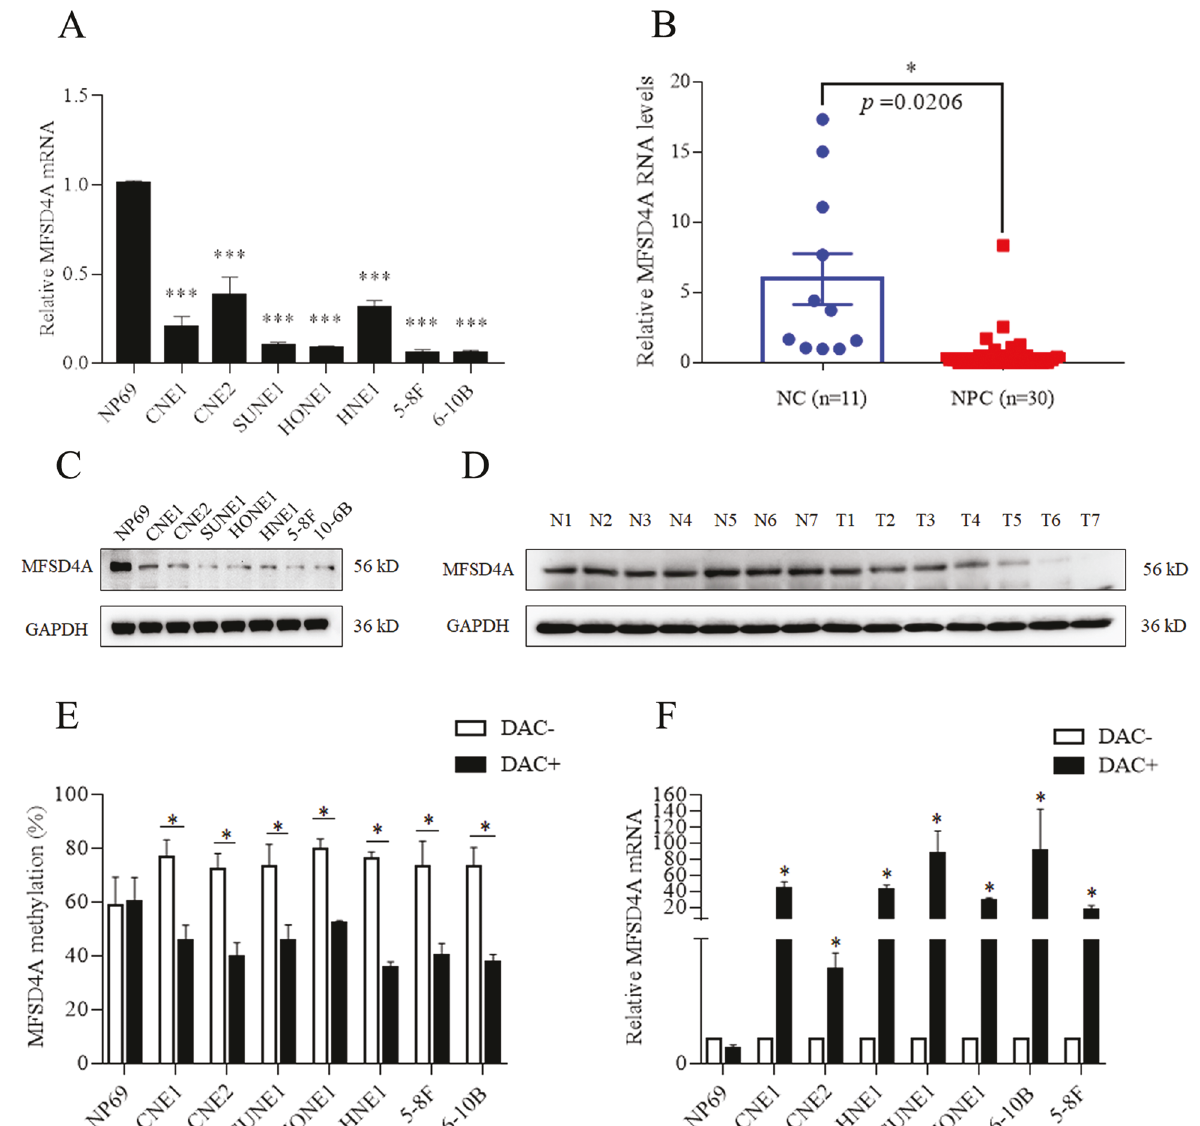
(DFS) (Fig. 8F, P = 0.014), and distant metastasis free survival (DMFS) (Fig. 8H, P = 0.039), but not loco-regional relapse free survival (LRRFS) (Fig. 8G, P = 0.199) compared with those in the MFSD4A-low group. MFSD4A was identi fi ed as an independent prognostic factor for